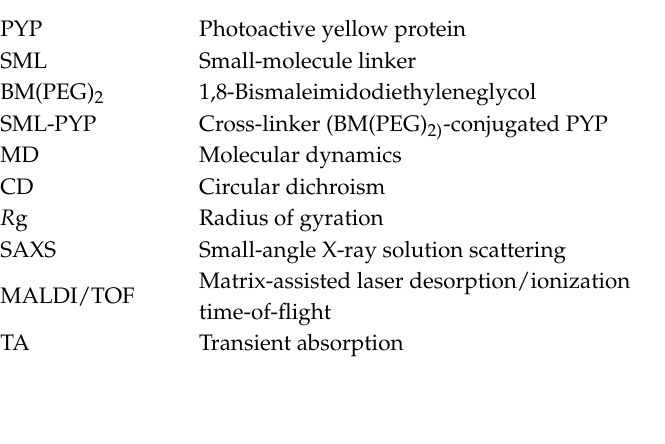
Figure S8: Comparison of DAMMIF-fit curves (black) and the experiment curves (red) from static SAXS data for SML-PYP in dark (a) and light (b) states for low-resolution shape reconstruction.; Figure S9: GNOM curve simulation (black) for SML-PYP in dark (a) and light (b) states.; Figure S10: Protein structures refined from the experiment-restrained rigid-body MD simulation and previous reported wild-type PYP and pB2 structure.; Figure S11: SAXS setup for SML-PYP in the light